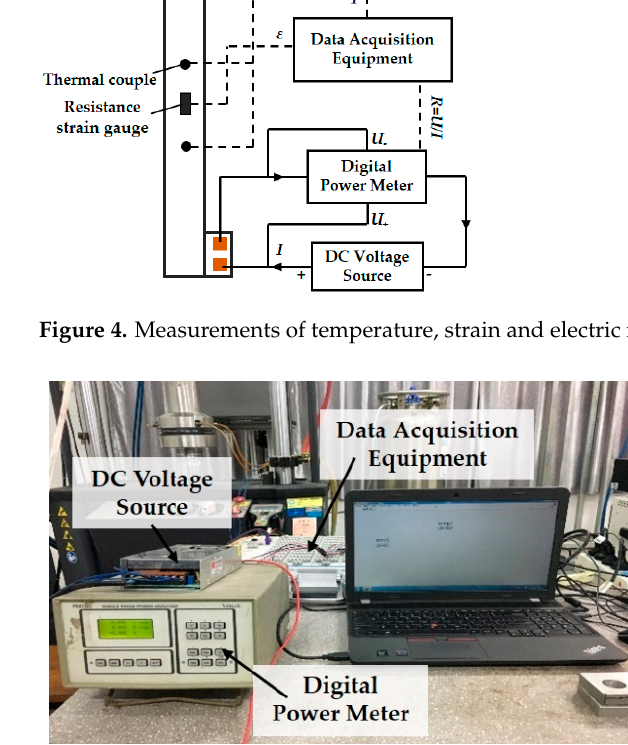
Figure 5. Apparatus used in the measurements.